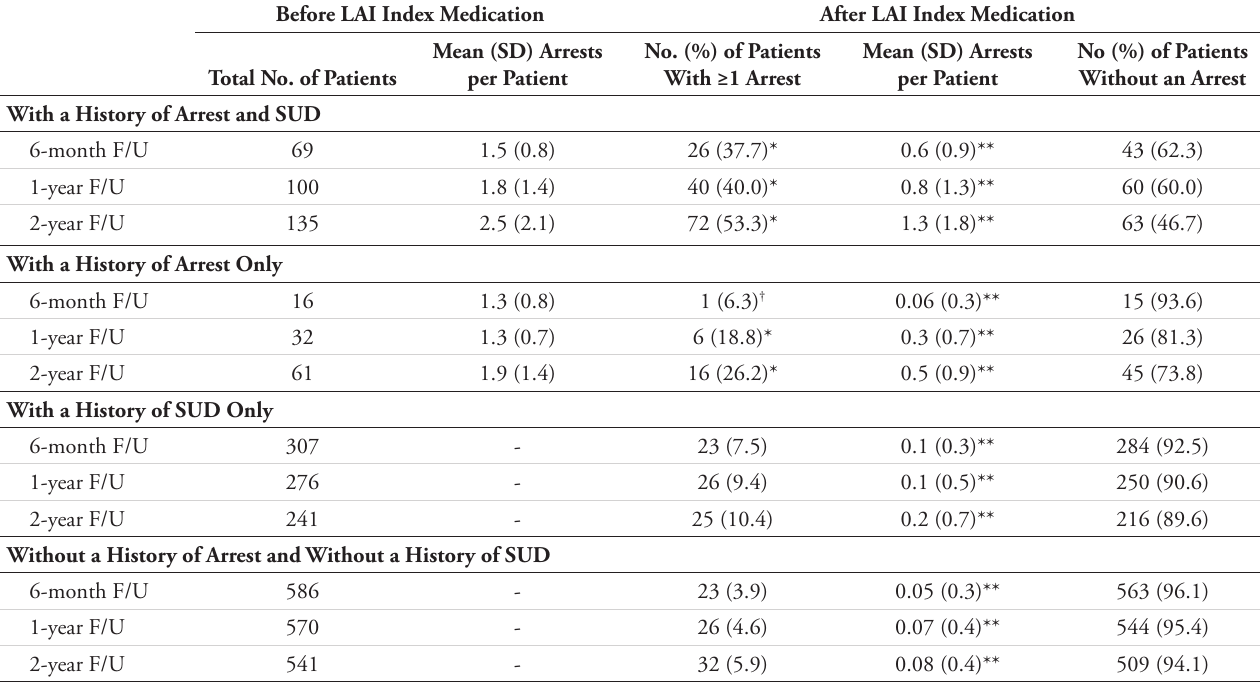
Table 2. Probability of Pre- and Post-LAI Antipsychotic Initiation Arrests in Persons with Schizophrenia or Schizoaffective Disorder With or Without a Prior History of Arrest and/or Substance Use Disorder Before LAI Index Medication